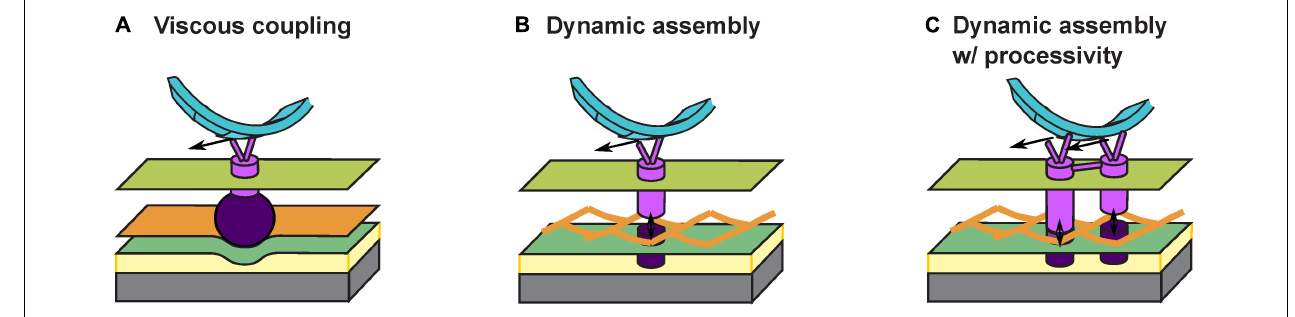
FIGURE 2 | Models for interaction between the gliding machinery and substrate. (A) Viscous coupling between the gliding machinery and substrate. Large motor-associated proteins (dark purple) may deform the PG and the resulting bump exerts a viscous force on the substrate as the proton channel motor (bright purple) moves. (B) Dynamic assembly of the force-generating gliding machinery. An inner subcomplex (bright purple) that includes the motor and an outer subcomplex (dark purple) that binds with the substrate bind with each other dynamically across the PG mesh to allow force generation without tearing the PG. (C) Dynamic assembly of coupled gliding machineries confers processivity. The dynamic binding between the inner (bright purple) and outer (dark purple) subcomplexes is similar to (B) . Coordinated activities of coupled motors keep the motors on the helical track and/or at the “focal adhesion” sites for an extended period of